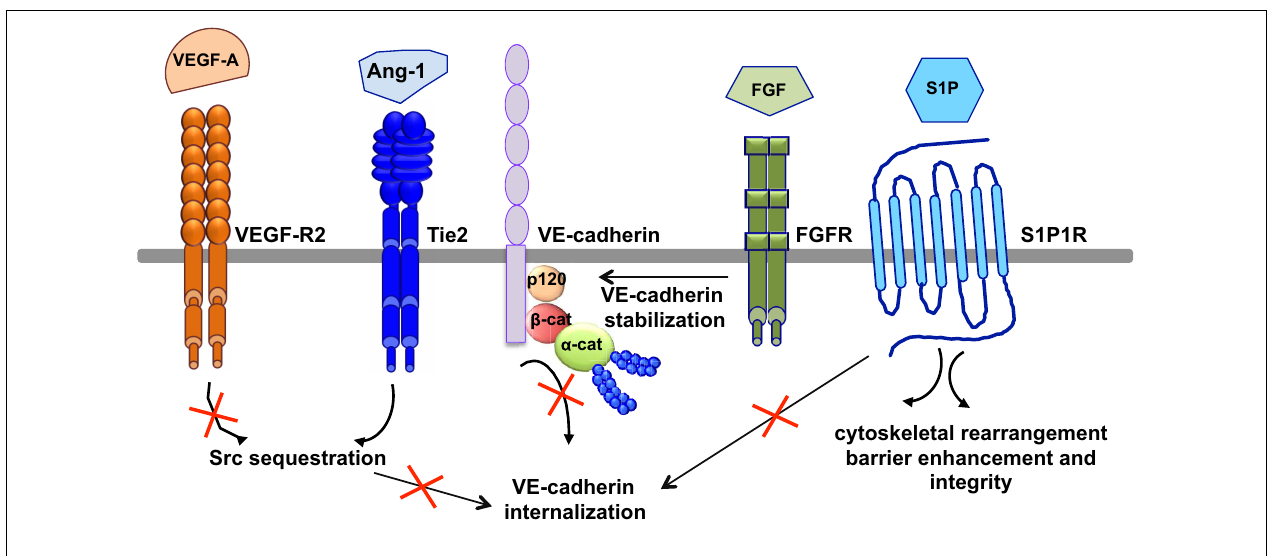
internalization. S1P signaling maintains vascular integrity by modulating VE-cadherin internalization, cytoskeletal rearrangement, barrier enhancement and integrity, through its cognate receptor S1P1R. FGF maintains the integrity of theVE-cadherin/p120-catenin complex, thus stabilizingVE-cadherin at the